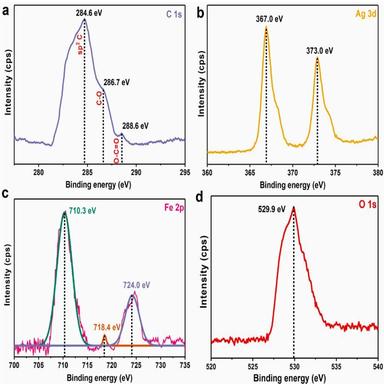
XPS spectra of (a) carbon (C 1 s), (b) silver (Ag 3d), (c) iron (Fe 2p), and (d) oxygen (O 1 s).